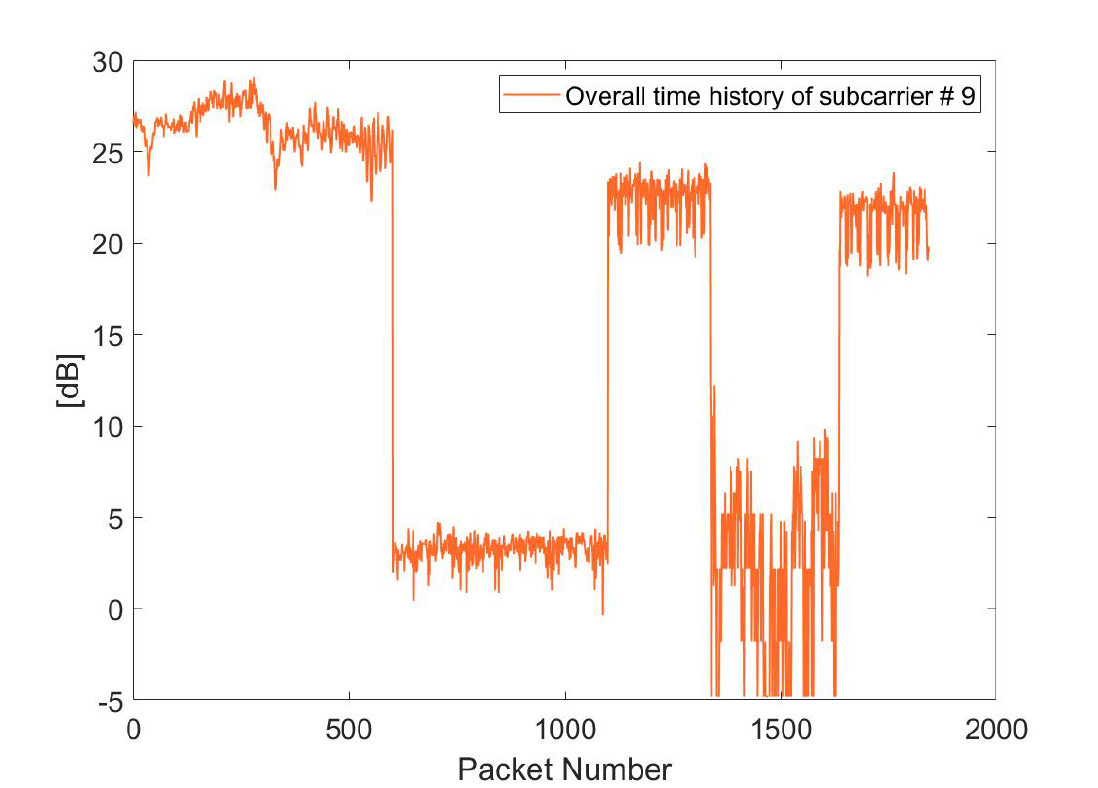
Figure 2. CSI-time history of each